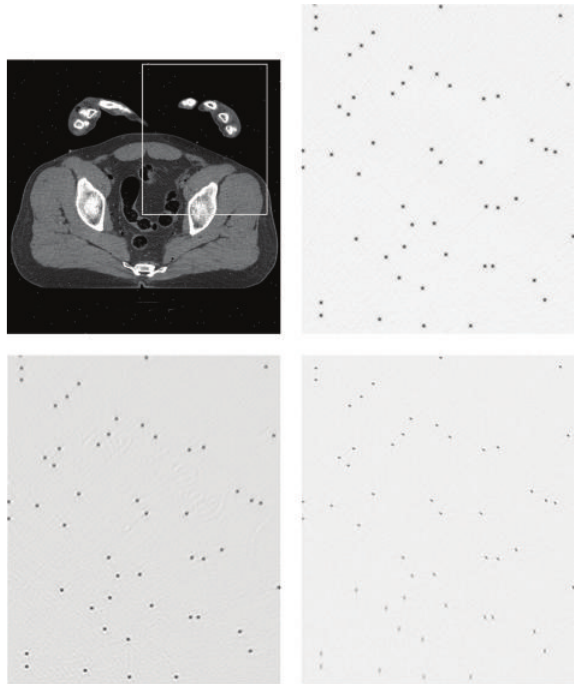
Figure 21: Upper left: reference image with added spikes. The LIR maps are shown in the marked region. Upper right: LIRs obtained withFBPreconstruction.Lowerrow,lefttoright:LIRmapsobtained with our algorithm and the PWLS.